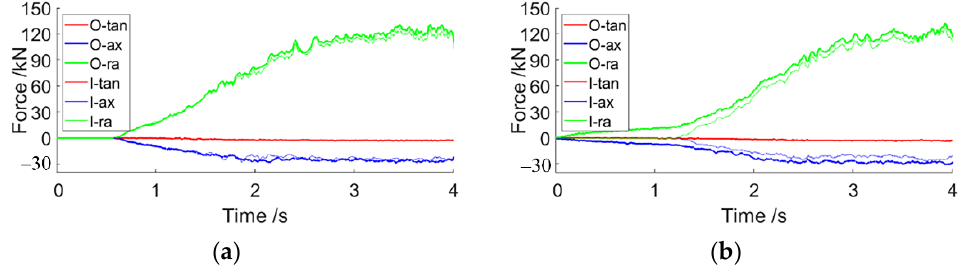
Figure 9. The flow-forming forces of inner roller and outer rollers with 35% thickness reduction within 4 s: ( a ) The SCRFF process; ( b ) The ACRFF process with −0.25 mm rollers’ offset position. (O-tan: the outer roller tangential force; O-ax: the outer roller axial force; O-ra: the outer roller radial force; I-tan: the inner roller tangential force; I-ax: the inner roller axial force; I-ra: the inner roller radial force).